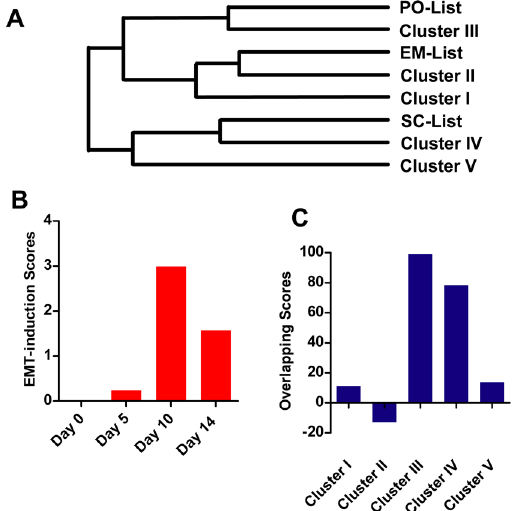
Fig 6. EMT during neuron trans-differentiation. (A) The 773-gene list in S5 Table was used to determine the correlation between PO-lists, EM-list, SC-list and gene lists identified in five clusters. Identification of the 773 genes in all the eight lists were remarked as “ 1 ” in S5 Table. The samples were merged in close proximity using the farthest neighbor clustering method in linkage criteria, i.e. complete linkage. (B) Four scoring systems mentioned above were used to evaluate the expression change during neuron trans-differentiation (GSE68902). (C) The expression changes on Day 10 during neuron trans-differentiation (GSE68902) were evaluated by gene listed from five clusters as described in Materials and Methods. Overlapping score was calculated by subtracting the absolute log2 values of genes with opposite expression changes from the summary of genes with consistent expression